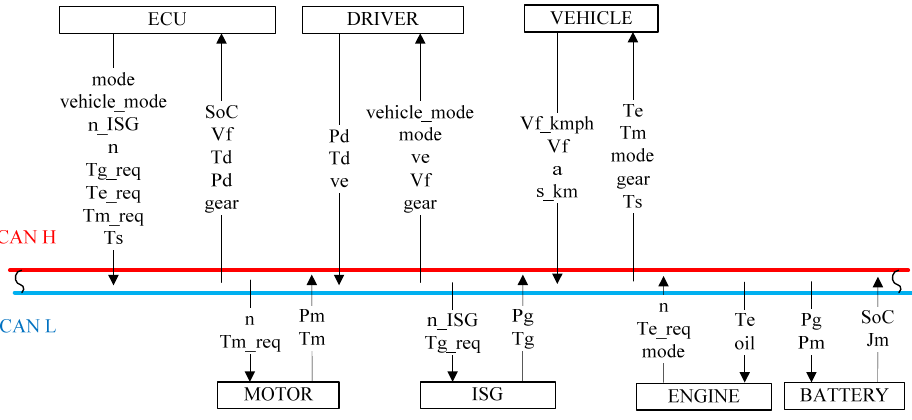
Figure 12. Nodes send and receive signals schematic diagram.